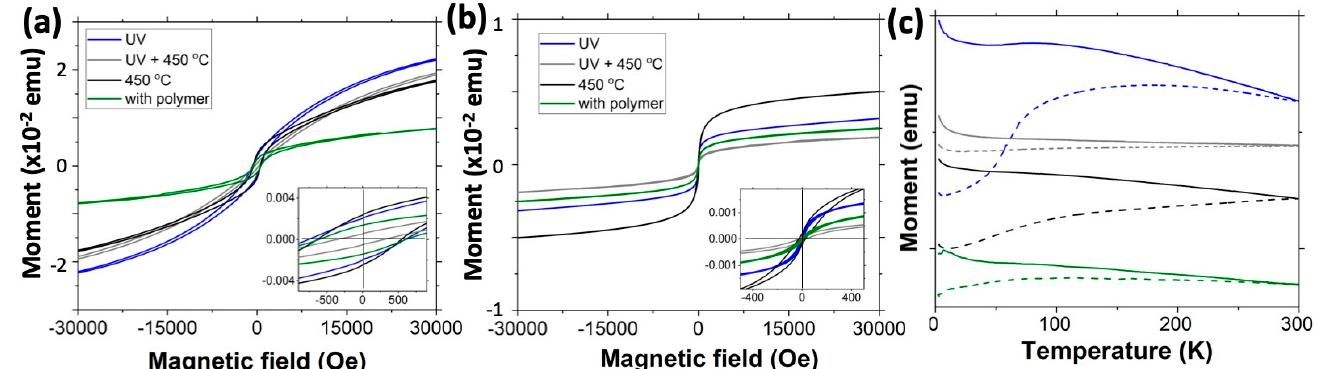
Figure 4. Magnetization (M) hysteresis loops at 5 K and 300 K ( a , b , respectively), and ( c ) zero-field cooled (ZFC, dashed curves) and field cooled (FC, solid curves) curves obtained with 100 Oe applied magnetic field for PS-P4VP template infiltrated with FeAA and alumina, and the iron oxide/alumina heterostructures with the polymer removed by UV ozone treatment and by thermal annealing.